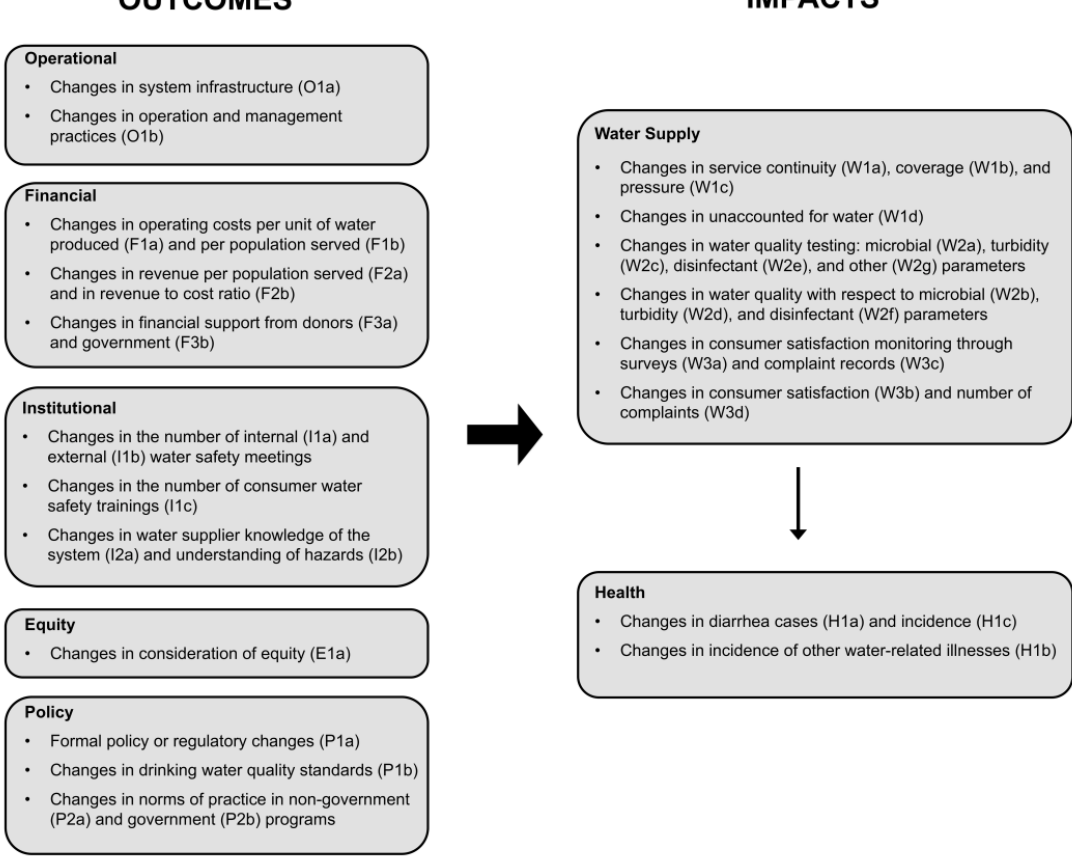
Figure 3. Operational impact assessment framework and indicators used in this study. More details on indicators, including units and sub-indicators, are presented in Table 2.